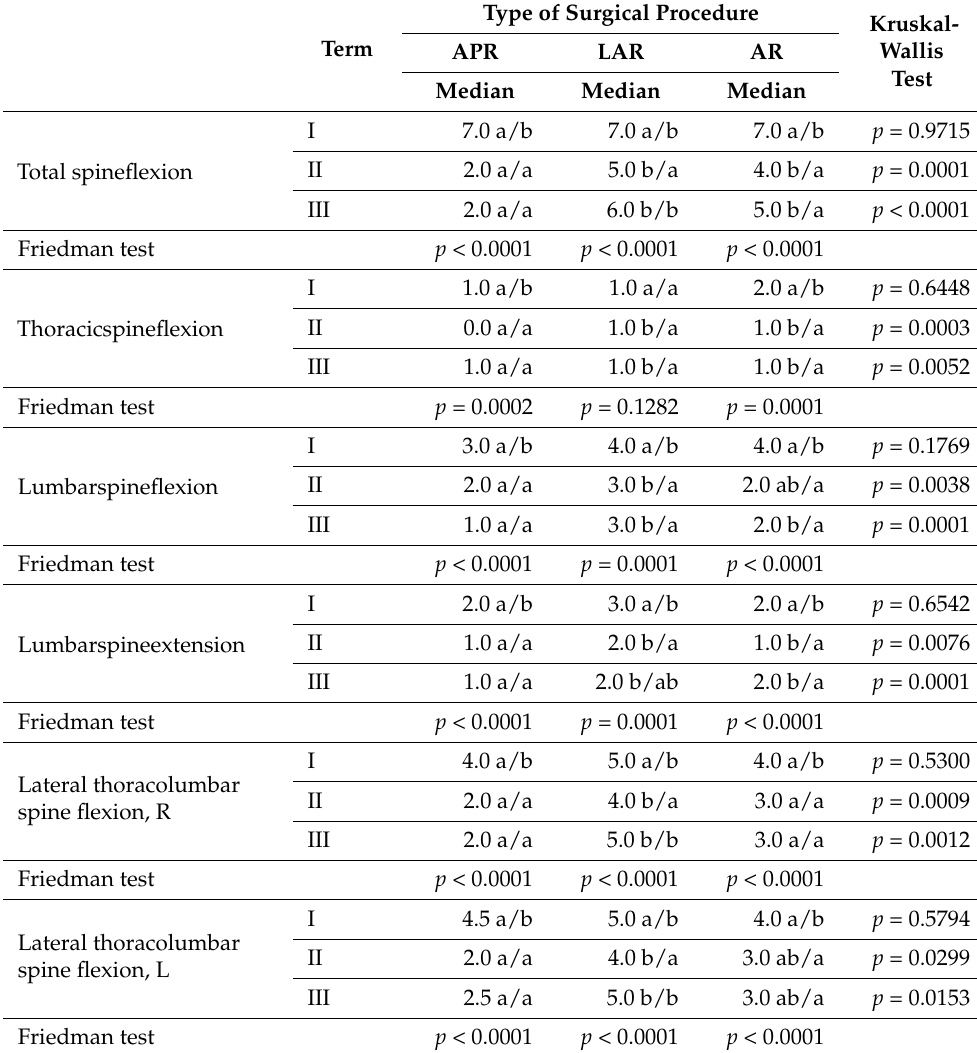
Table 3. Mobility of spine joints, evaluation of strength of the abdominal muscles and assessment of chest mobility in the study groups (abdominoperineal resection, anterior resection and laparoscopic anterior resection) and the differences between those groups foreach